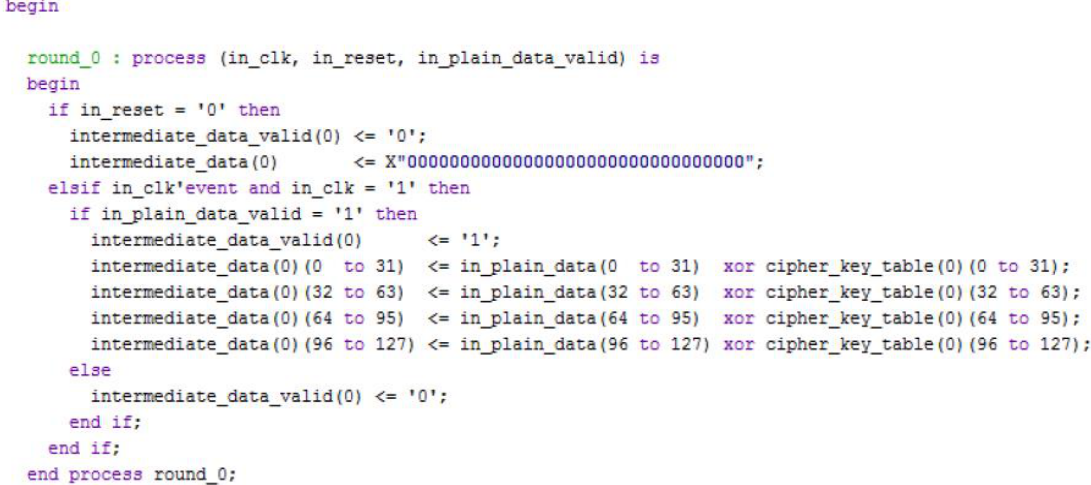
Figure 12. Code Section related to the first round (called round_0) of the AES-128 algorithm.